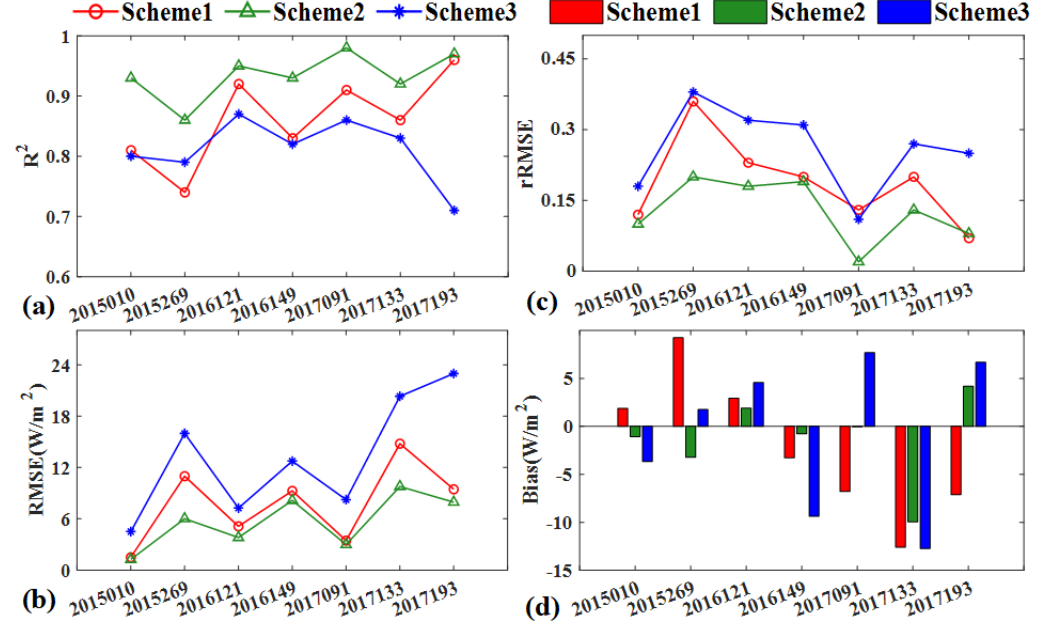
Figure 7. ( a ) R 2 , ( b ) RMSE, ( c ) rRMSE, ( d ) bias comparison between the estimated LE and the reference LE on the validation dates.